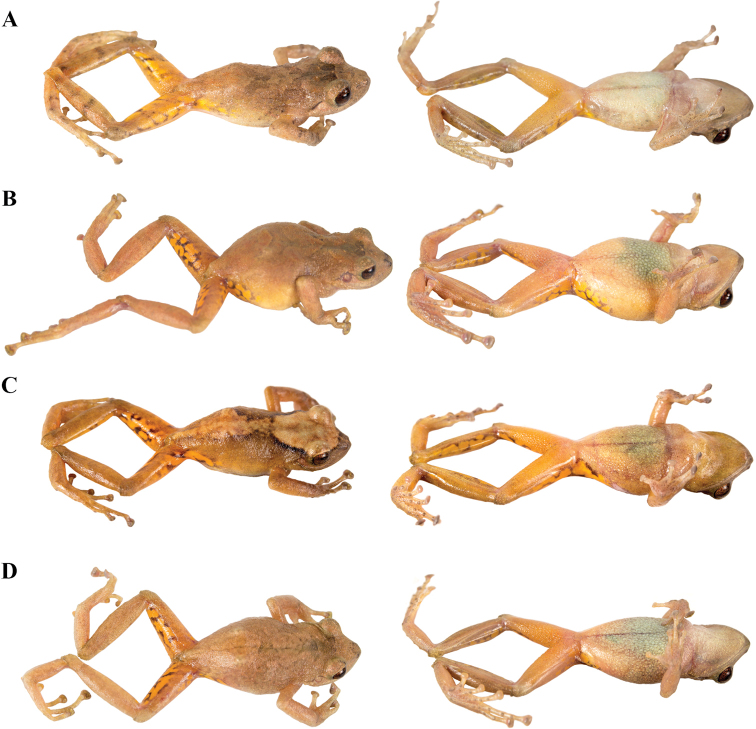
Color variation in live individuals of Pristimantis
phoxocephalus. AQCAZ 58461 (male, SVL 29.9 mm) BQCAZ 58463 (female, SVL 36.1 mm) CQCAZ 58470 (male, SVL 26.7 mm) DQCAZ 58472 (female, SVL 34.2 mm). Dorsolateral view on the left, ventral view on the right.